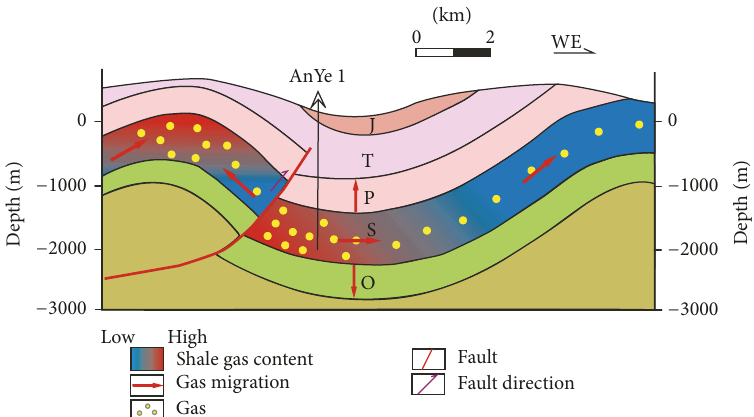
Figure 9: Shale gas accumulation diagram of Anchang Area, North Guizhou. See Figure 1 for the location.